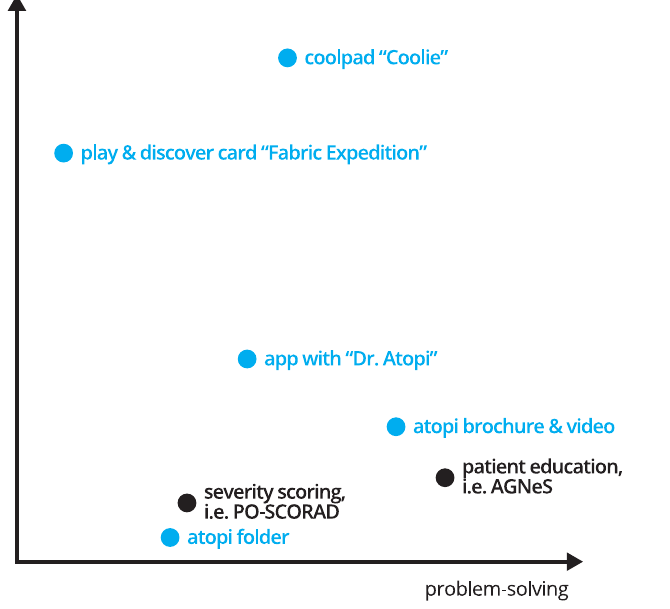
Figure 6. Projection of existing approaches and atopi elements along the two axes “problem-solving” and “possibility-driven”. Black = existing approaches, blue = atopi elements. The problem-solving axis does not count the numbers of solved problem, nor does the possibility-driven axis reflect the number of created possibilities. Instead, the diagram is a visualization of the authors’ perception of the potential of the single